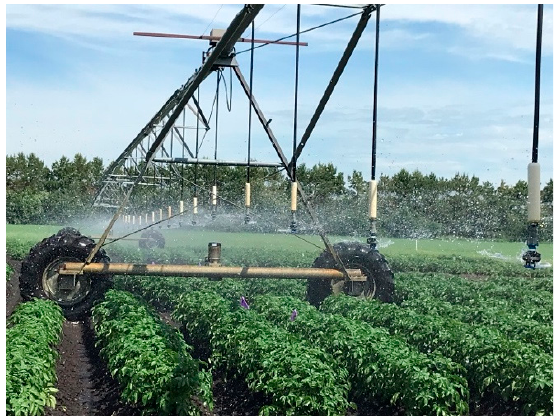
Figure 8. Irrigation system used in the field trials in Manitoba, Canada (photo was taken by Dr. Tracy Shinners-Carnelley).